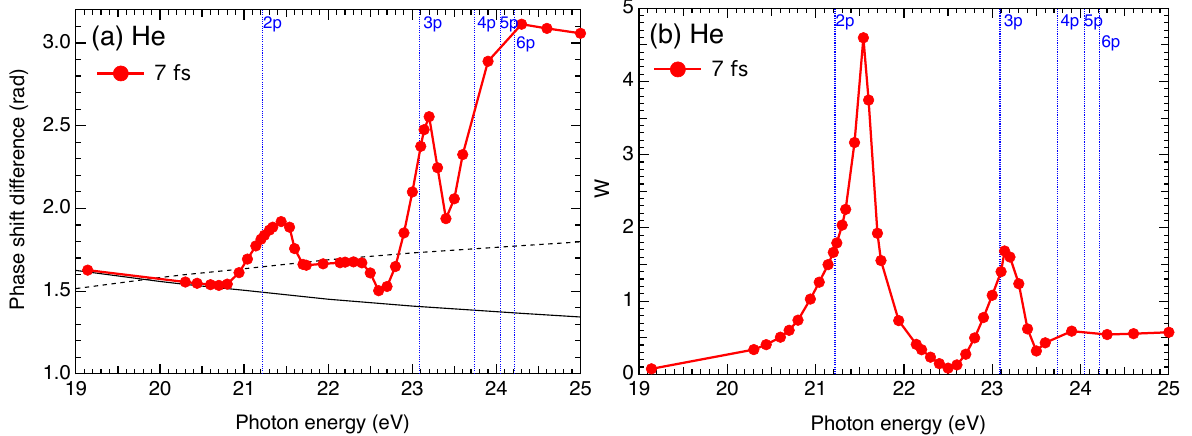
Figure 7. Photon-energy dependence of ( a ) the relative phase (phase-shift difference) δ and ( b ) the amplitude ratio W between the S and D wave packets for a pulse width of 7 fs. The target atom is helium. Thin sold and dashed lines in ( a ): | δ Vertical dotted lines: positions of 1 s 2 p 1 P to 1 s 6 p 1 P